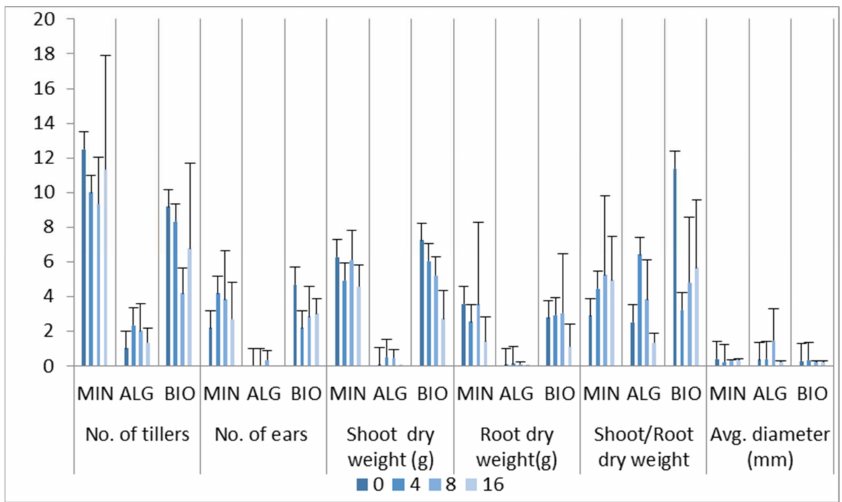
Figure 3. The effects of salinity stress and fertilizer types on leaf area and root area during the early growth stage (7 weeks) for Rehan barley cultivar (MIN: mineral fertilization, BIO: biochar with mineral fertilization, ALG: dried algae biomass powder from freshwater (0, 4, 8, 16 mS/cm EC are the salinity concentrations in soil). The mean value and standard deviation are